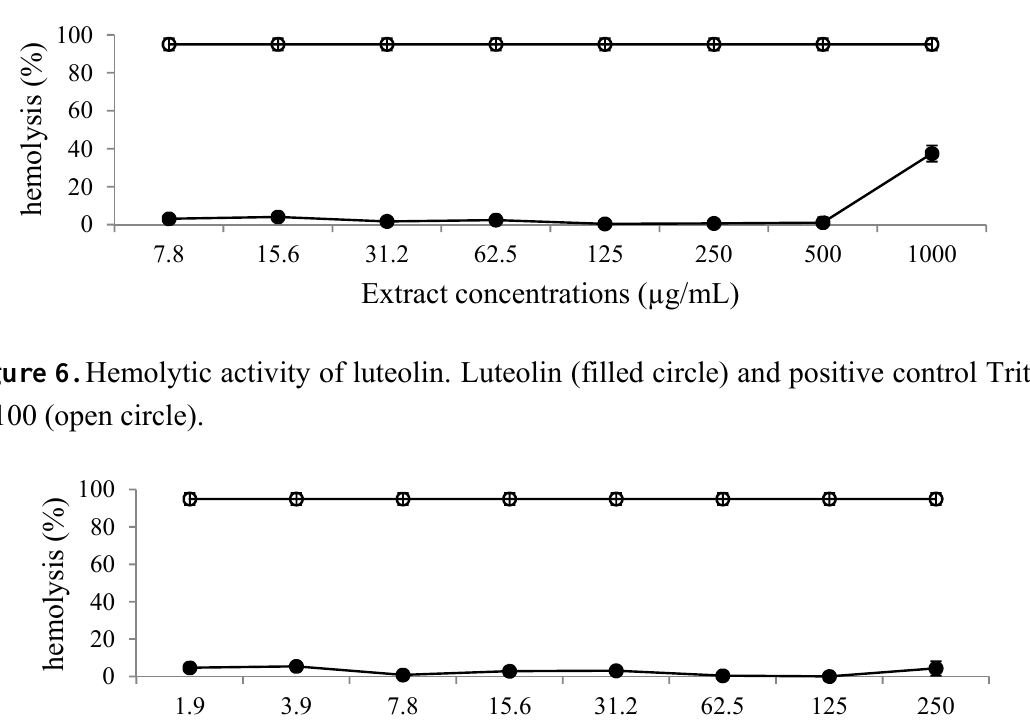
Figure 5. Hemolytic activity of extract of leaves of L. spiralis. Extract (filled circle) and positive control Triton X-100 (open circle).